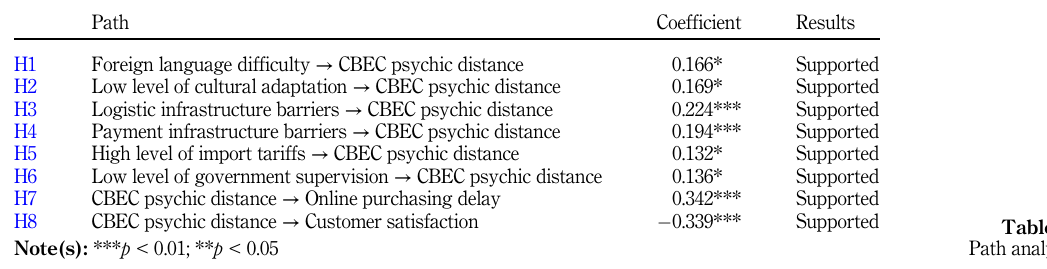
Figure 4. The result of research